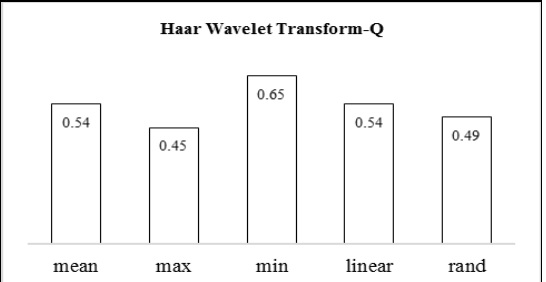
Figure 9. Q factor for different